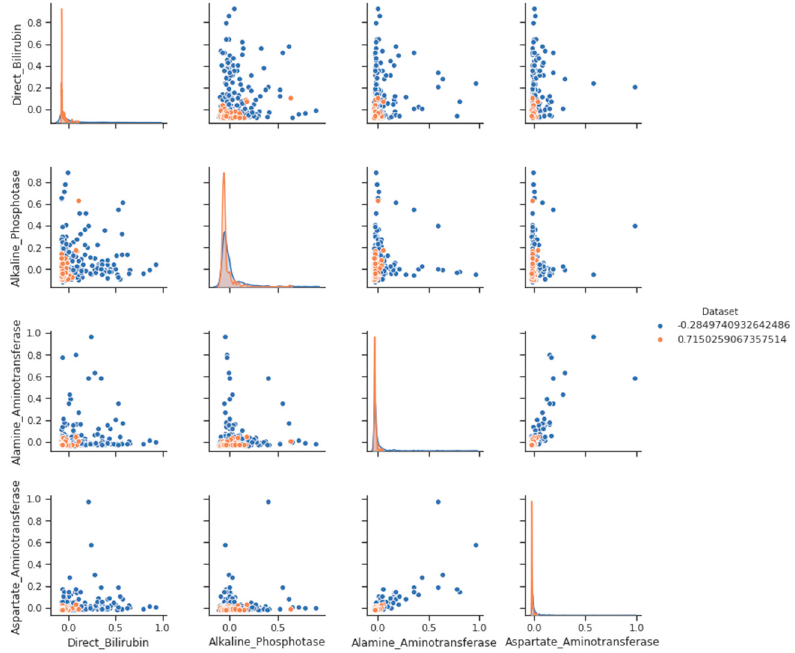
Figure 3. Pair Plot- a liver disease with label categories.